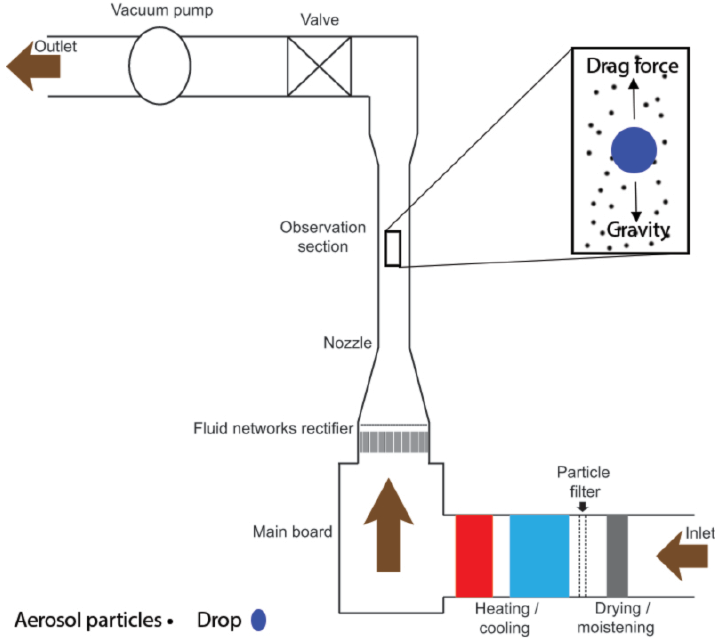
Fig. 6. Schematic of the wind tunnel experimental setup and its major components (Diehl et al., 2011; Szakáll et al.,